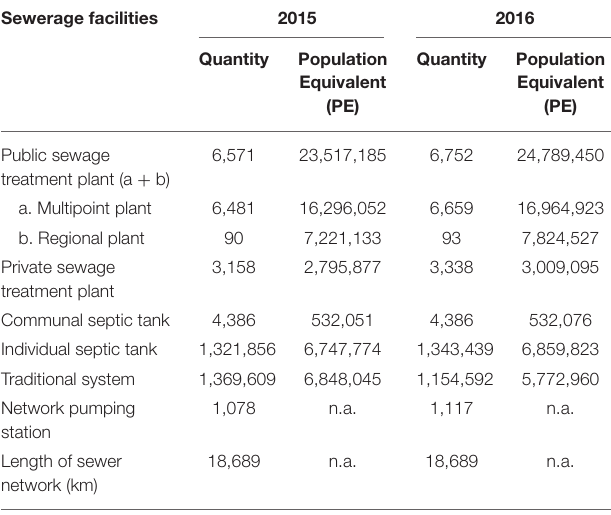
TABLE 1 | Profile of sewerage systems in